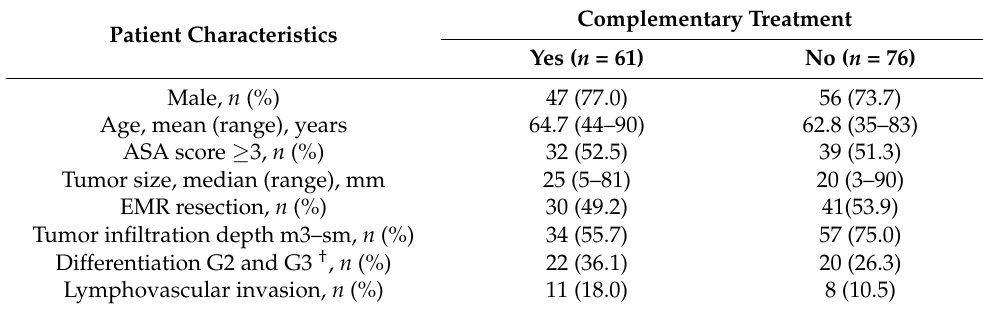
Table 2. Characteristics of adjuvant chemoradiotherapy or/and surgery.